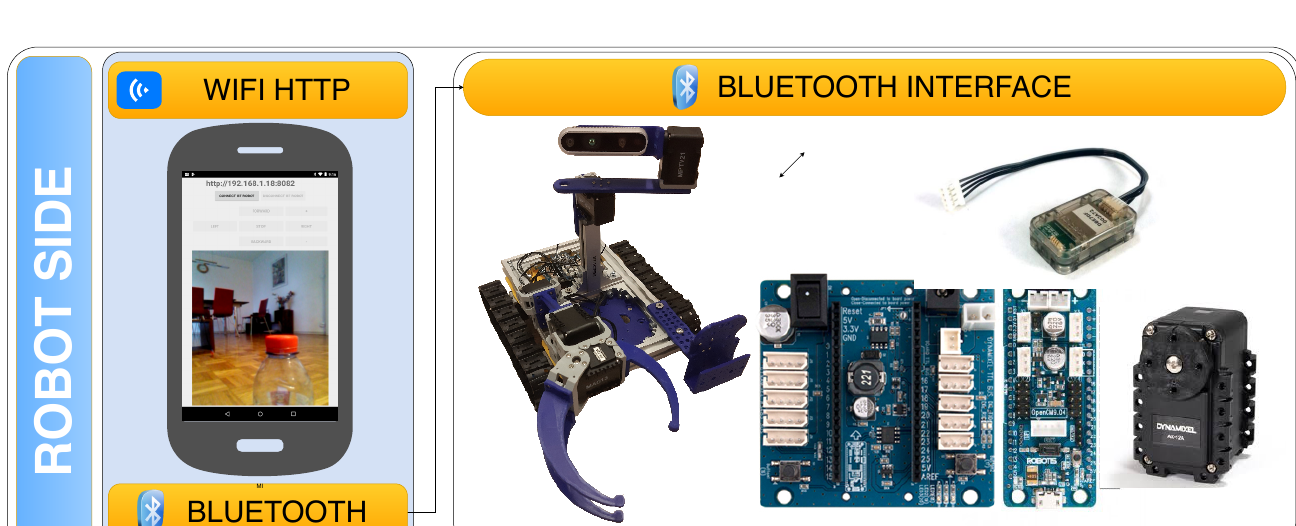
Figure 23. MiniCERNBot educational robotic platform software